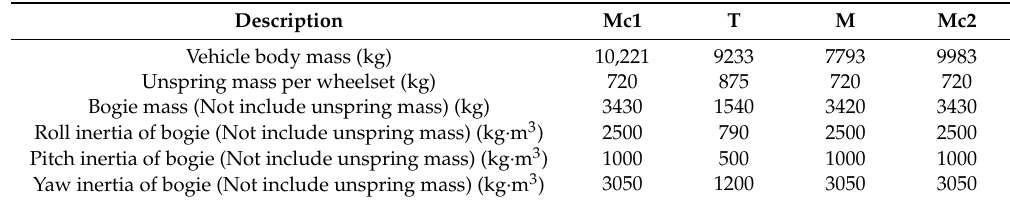
Table 2. Basic simulation parameters of the low-floor tram.